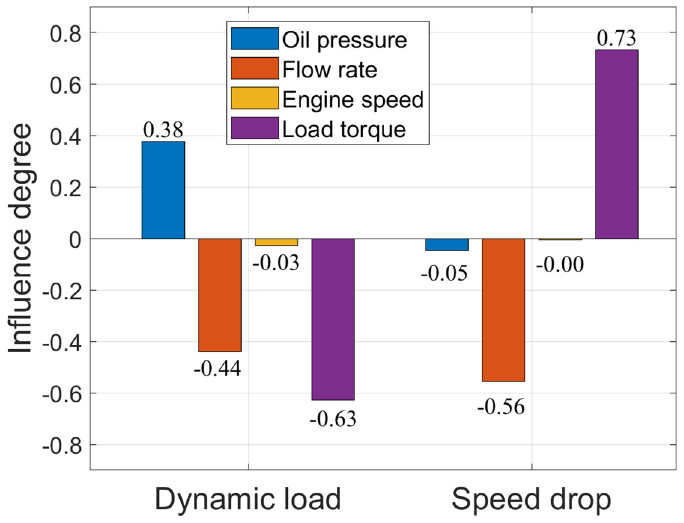
Figure 7. Calculation results based on PLS.